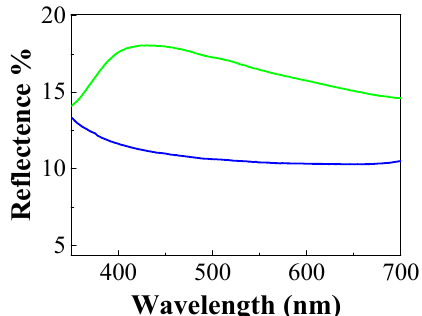
Figure 7. Total reflectance spectra of: CsI(Tl) scintillator (blue curve) and CsI(Tl) scintillator coated by a BaSO 4 /epoxy layer (green curve).